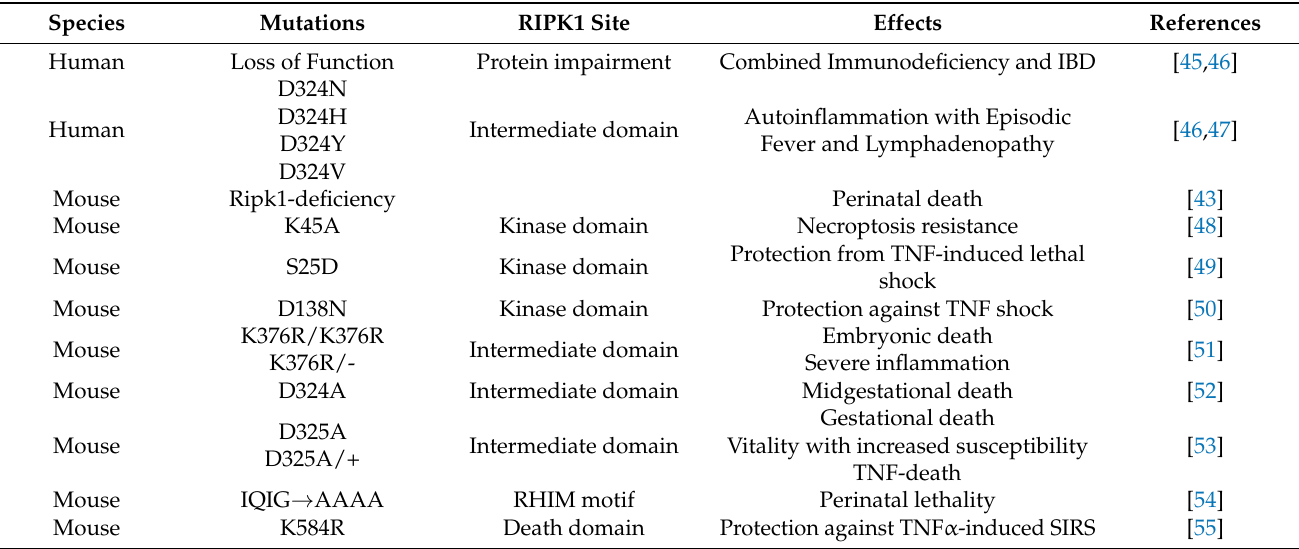
Table 1. RIPK1 in vivo mutations and its main